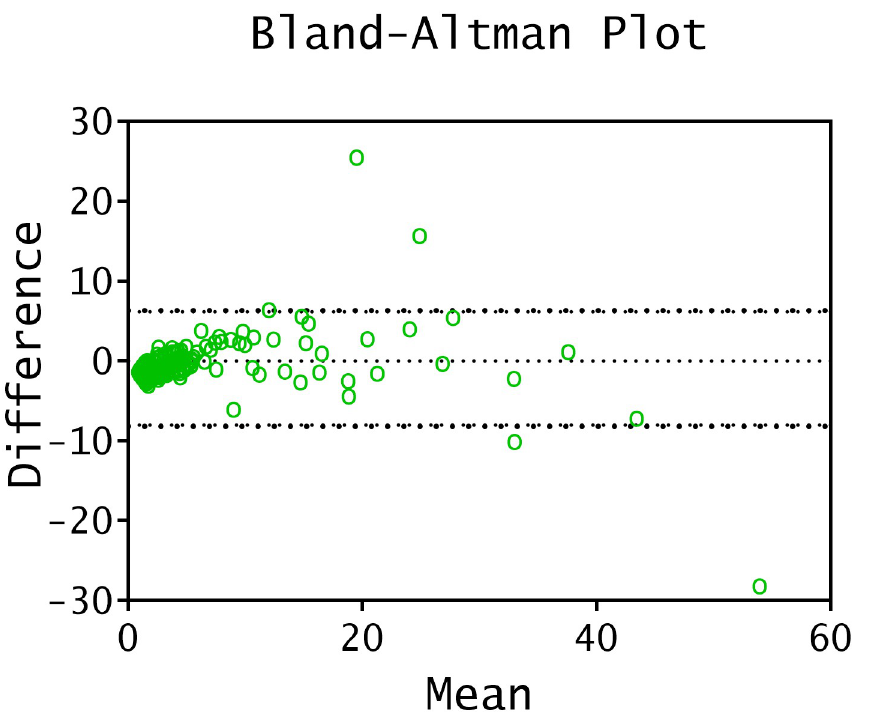
Fig 3. Bland-Altman plot. Inter-assay agreement between EliA ™ and Elecsys 1 TRAb. The dashed line (........) corresponds to bias. Lower (-8.036) and upper (6.195) 95% limits of agreement are plotted as speckled lines. Y-axis plots the difference scores of EliA ™ and Elecsys 1 TRAb measurements against the mean for each studied sample.